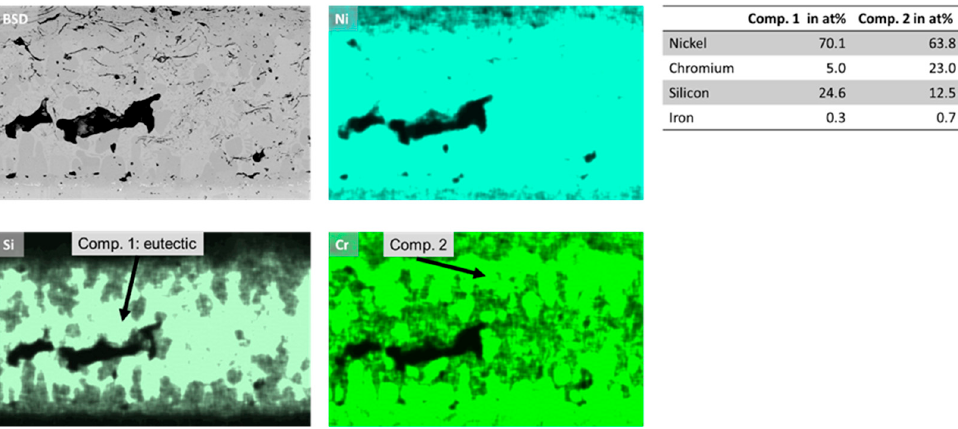
Figure 8. SEM micrographs (back-scattered electron detector mode) including element distribution of the filler metal layer. of the filler metal